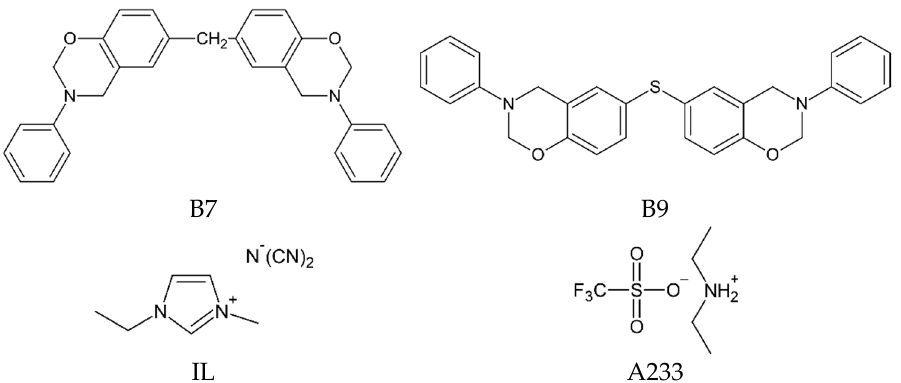
Figure 1. Chemical structures of tested benzoxazine resins and latent curing agents: B7—benzoxazine resin Araldite MT 35700; B9—benzoxazine resin Araldite MT 35910; IL—1-ethyl-3-methylimidazolium dicyanamide; A233—diethylamine salt of trifluoromethanesulfonic acid. Table 1. Characteristic of tested benzoxazine resins [13].